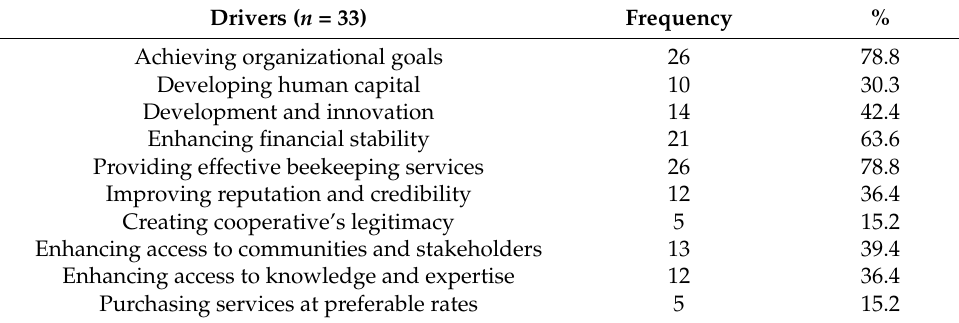
Table 2. Motivations of creating partnerships.